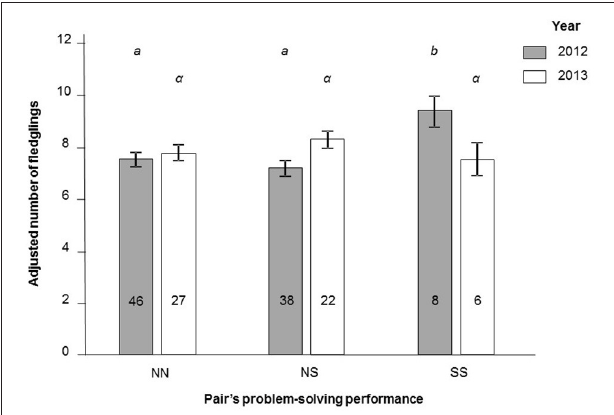
FIGURE 1 | Final number of fledglings (least square means ± SE) according to pair’s problem-solving performance (NN, pairs where both parents were non-solvers; NS, pairs with one solver; SS, pairs with two solvers) and year (2012, 2013) in a natural population of great tits. Values are adjusted for the other significant effect of the model, i.e., effect of brood size treatment. Letters represent results of Tukey HSD test, where different letters are attributed to significantly different groups. Numbers are sample sizes.